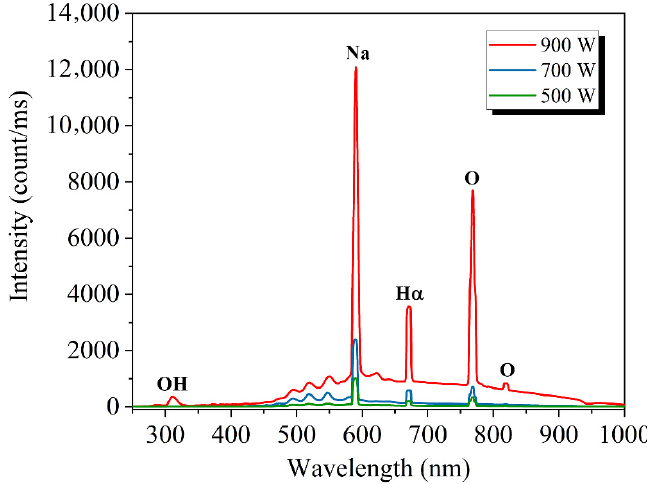
Figure 6. Spectral data of water vapor plasma with different power.